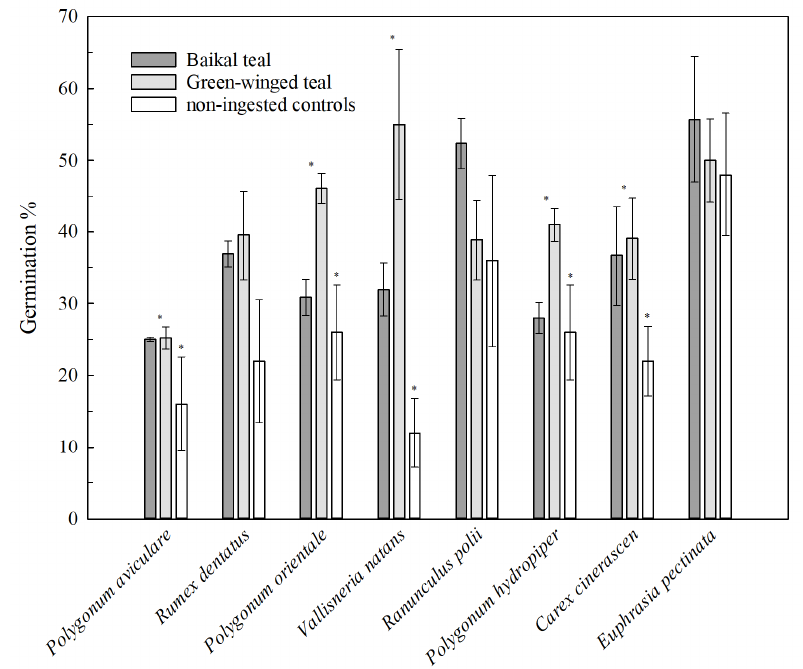
Figure 2. The rate of germinated seeds ( ± SE) ingested by Baikal teal and Green-winged teal vs. non-ingested controls. * represents the significance of the difference in germination between the experimental and control group of each seed species.